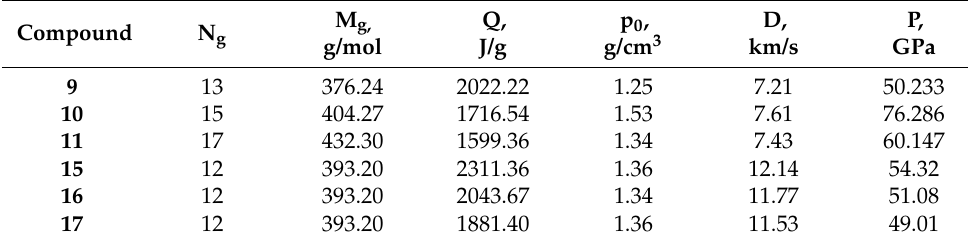
Table 4. The calculated values of the detonation properties of compounds 9 – 11 and 15 – 17